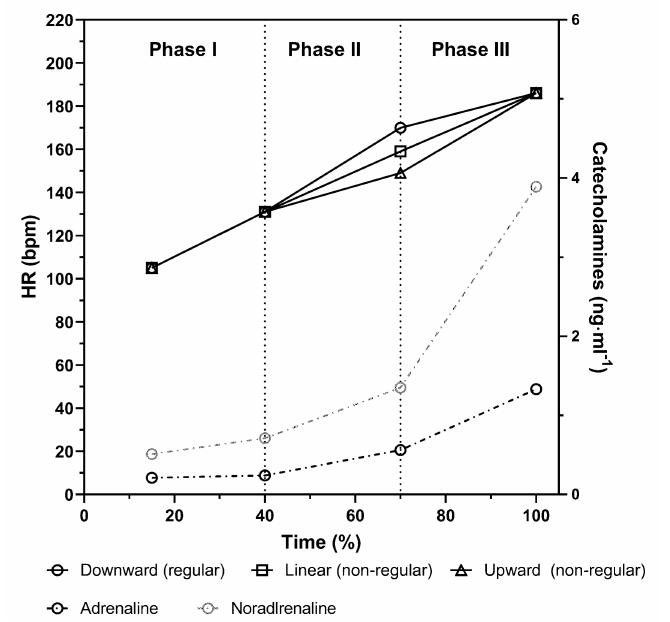
Figure 1. Schematic 3—phase model of the heart rate performance curve (HRPC) during incremental cycle ergometer exercise with downward deflection (regular), linear course or upward deflection (non-regular) (solid black lines) as well as plasma adrenaline and noradrenaline concentrations (dashed and dash-dotted black and grey lines) (modified from Hofmann et al. and Pokan et al.